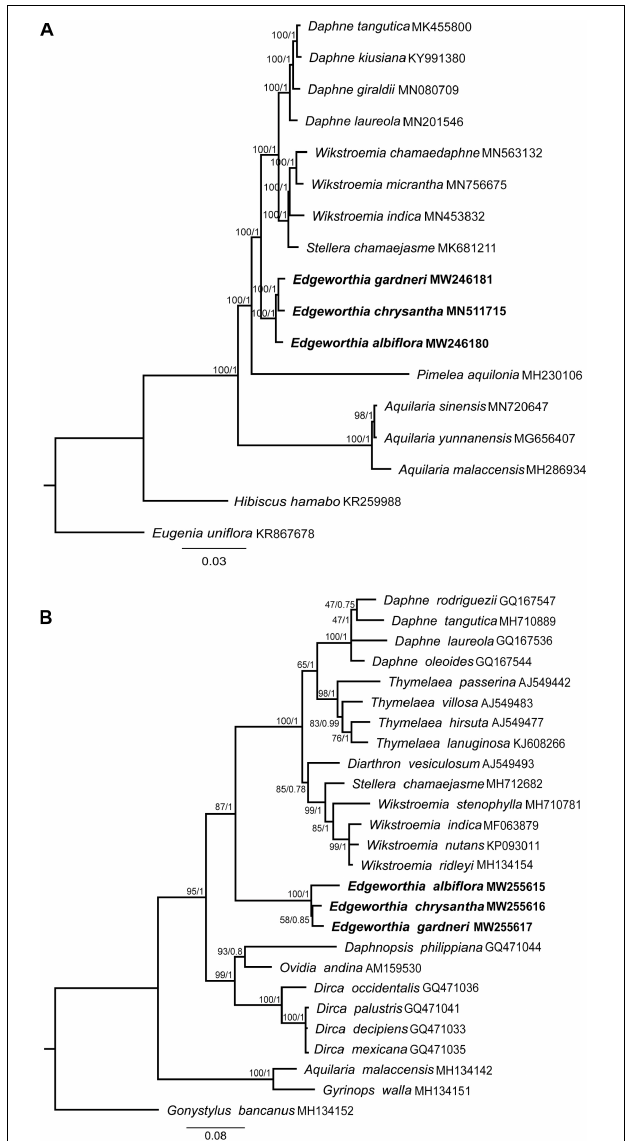
FIGURE 6 | Maximum-likelihood (ML) and MrBayes (BI) tree analyses were based on 1,000 bootstrap replicates. Bootstrap support values and Bayesian posterior probabilities are indicated at each branch nodes. Three species of Edgeworthia used in this study are highlighted in bold. (A) Combined phylogenetic tree of Edgeworthia and allied genera based on the chloroplast genome sequences of 15 taxa from Thymelaeaceae. Two related species, Hibiscus hamabo (Malvaceae; KR259988) and Eugenia uniflora (Myrtaceae; KR867678) were included as outgroups. (B) Phylogenetic analyses of Thymelaeaceae based on nuclear ribosomal DNA internal transcribed spacer (ITS) gene sequences. A total of 23 ITS sequences from the members of Thymelaeaceae, representing 21 taxa from eight genera in the Daphne group of tribe Daphneae, two taxa from tribe Aquilarieae and one taxon from subfamily